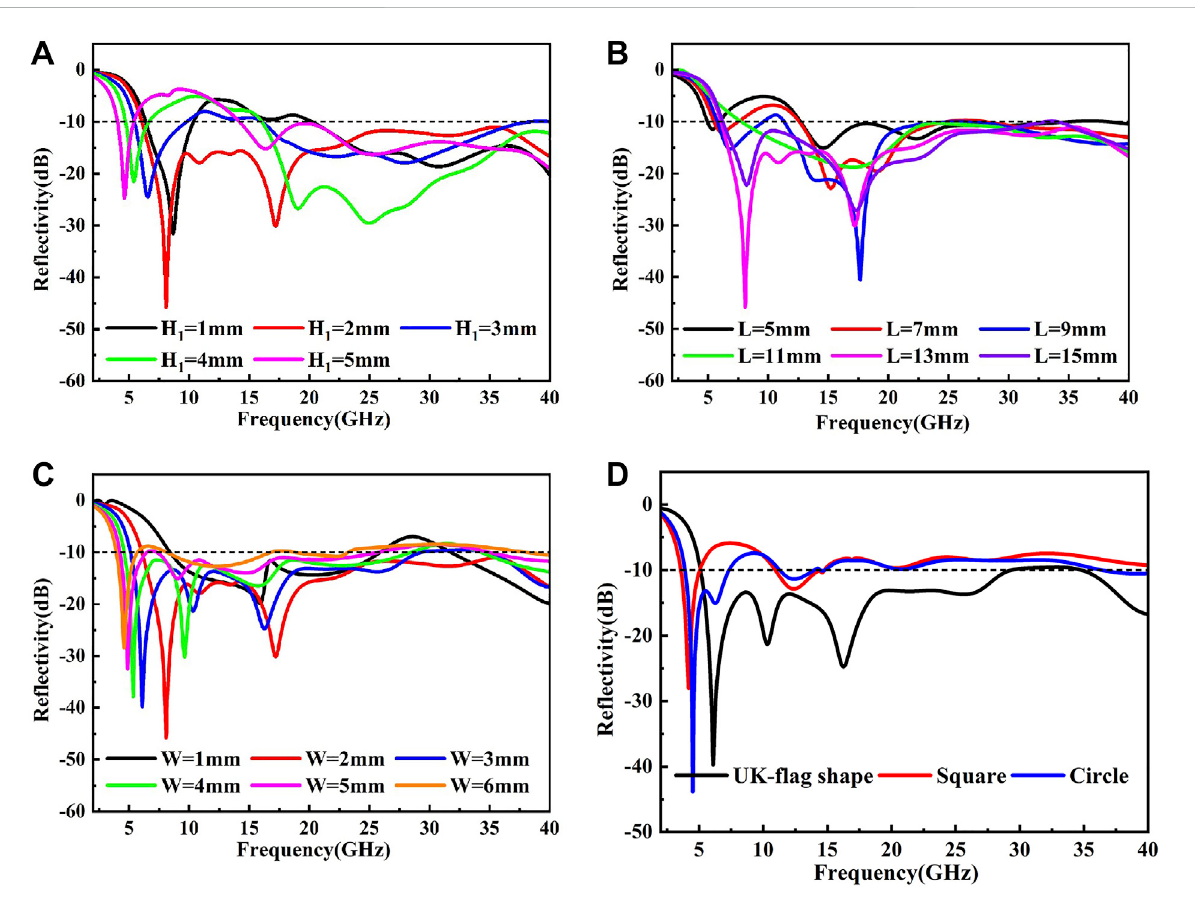
FIGURE 3 In fl uence of different structural parameters in the unit cell of (A) H 1 ; (B) L; (C) W, and (D) the surface shape on the re fl ectivity in the frequency range of 2 – 40